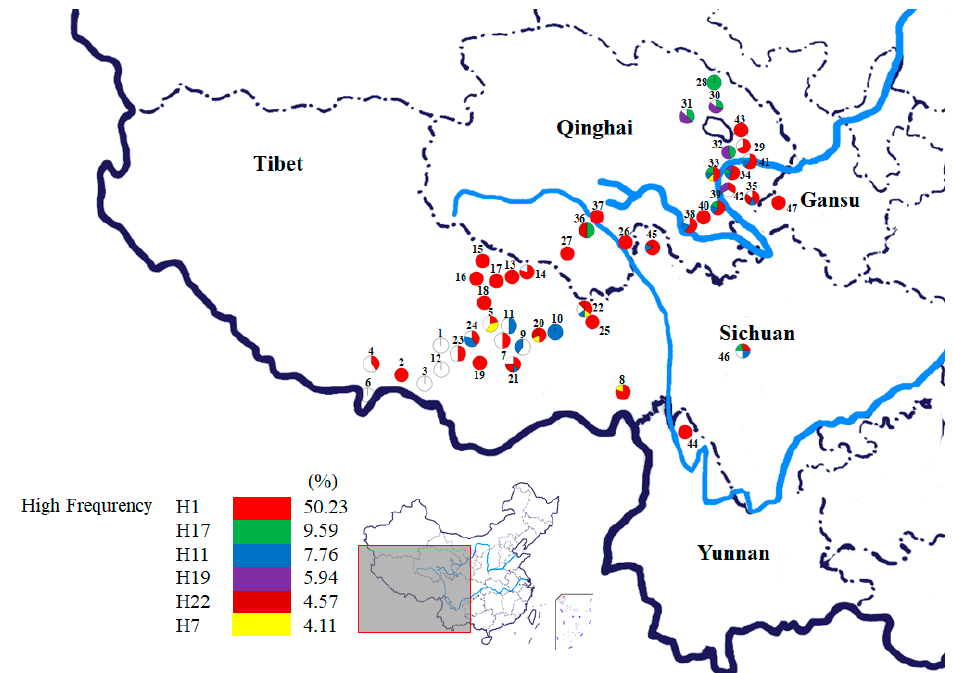
Figure 2. Geographical distribution map and NADPH-cytochrome P450 reductase-2 gene haplotype frequencies of 47 O. sinensis populations collected across the major distribution regions in China. Population codes correspond to those in Table S1. The haplotypes with high frequency are color-coded, while haplotypes with low frequency are represented by white